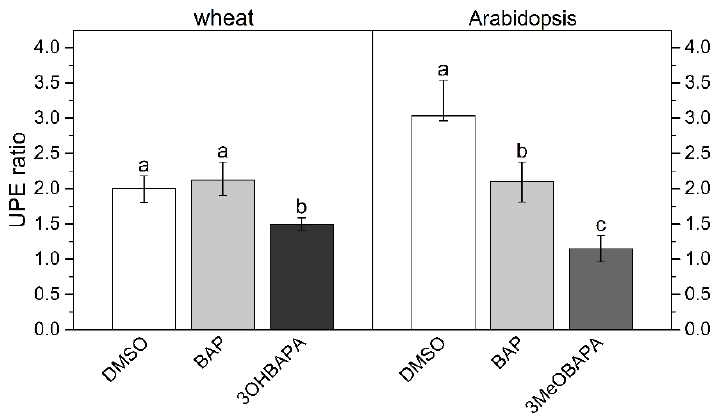
Figure 6. Ratio of ultra-weak photon emission (UPE) intensity after/before application of H 2 O 2 in detached leaves of wheat and Arabidopsis dark-incubated for 6 days in 0.1% DMSO or 10-µmol·L − 1 solutions of BAP, 3OHBAPA or 3MeOBAPA. Medians and quartiles are presented ( n = 4). Different letters indicate a statistically significant difference between treatments within a plant species ( p < 0.05; Student’s unpaired t -test).